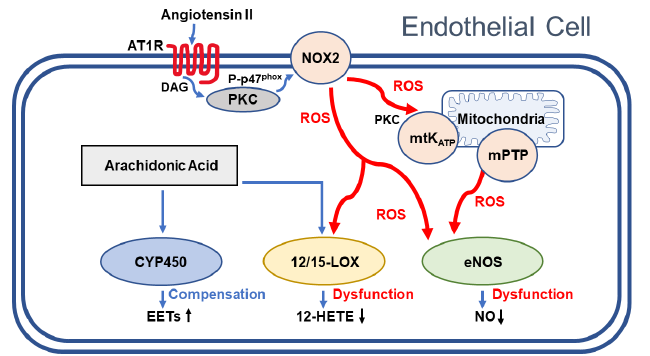
Figure 6. Proposed hypothetical signaling pathways affected by Ang II in the mouse ophthalmic artery endothelium. Activation of the angiotensin receptor type 1 (AT1R) by angiotensin II activates NADPH oxidase 2 (NOX2) in the cytoplasmic membrane via diacylglycerol (DAG), protein kinase C (PKC), and phosphorylation of the NADPH oxidase subunit p47 phox to P-p47 phox . Moreover, NOX2-derived ROS were shown to open mitochondrial KATP channels (mtKATP) in the mitochon- drial membrane subsequently causing the opening of permeability transition pores (mPTP) provid- ing an amplification mechanism for Ang II-induced oxidative stress. The ROS signaling mechanism is summarized from previous publications [9,56,64]. Based on our findings, NOX2-derived reactive oxygen species (ROS) inactivate endothelial nitric oxide synthase (eNOS), which leads to dimin- ished nitric oxide (NO) production. Moreover, impairment of 12/15-lipoxygenase (12/15-LOX) by ROS may blunt the generation of 12-hydroxyeicosatetraenoic acid (12-HETE), which is the predom- inant HETE regioisomer in the mouse and which appears to act as an endothelium-derived hy- perpolarizing factor (EDHF) [65]. In contrast, cytochrome P450 oxygenases (CYP450), which con- tribute to EDHF-mediated vasodilation by the generation of epoxyeicosatrienoic acids (EETs), ap- pears to be unaffected by Ang II-induced ROS formation and appears to compensate for the dys- functional eNOS- and 12/15 LOX-dependent signaling pathways.